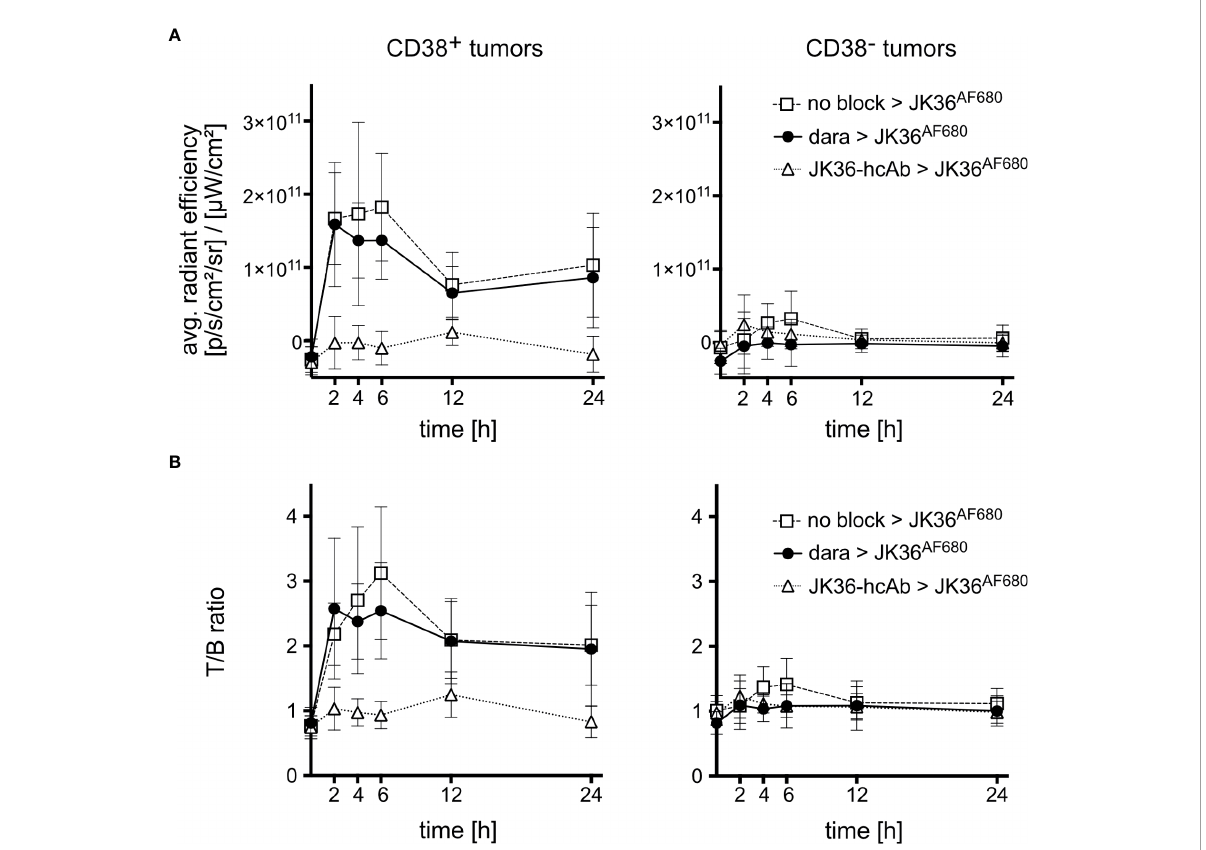
FIGURE 5 Average radiant ef fi ciencies and tumor-to-background ratios of CD38-positive and CD38-negative tumors in vivo . Mice were pretreated for 24 hours with either isotonic saline (n=10, positive control, open rectangles), daratumumab (n=10, black circles), or JK36-hcAb (n=10, speci fi city control, open triangles). Near-infrared fl uorescence in vivo imaging was performed before and at the indicated time points after injection of nanobody JK36 AF680 . (A) Average radiant ef fi ciencies were determined from circular regions of interest (ROIs) drawn around CD38-positive and CD38-negative tumors. Signal intensities were corrected for background signal. (B) Tumor-to-background ratios were obtained by dividing tumor signals by background signals obtained from ROIs drawn around normal tissue (hind leg). At all time points, there was no statistically signi fi cant difference in signal intensities and T/B-ratios of CD38-positive tumors between saline-pretreated and daratumumab-pretreated mice, as indicated by overlapping 95%-con fi dence